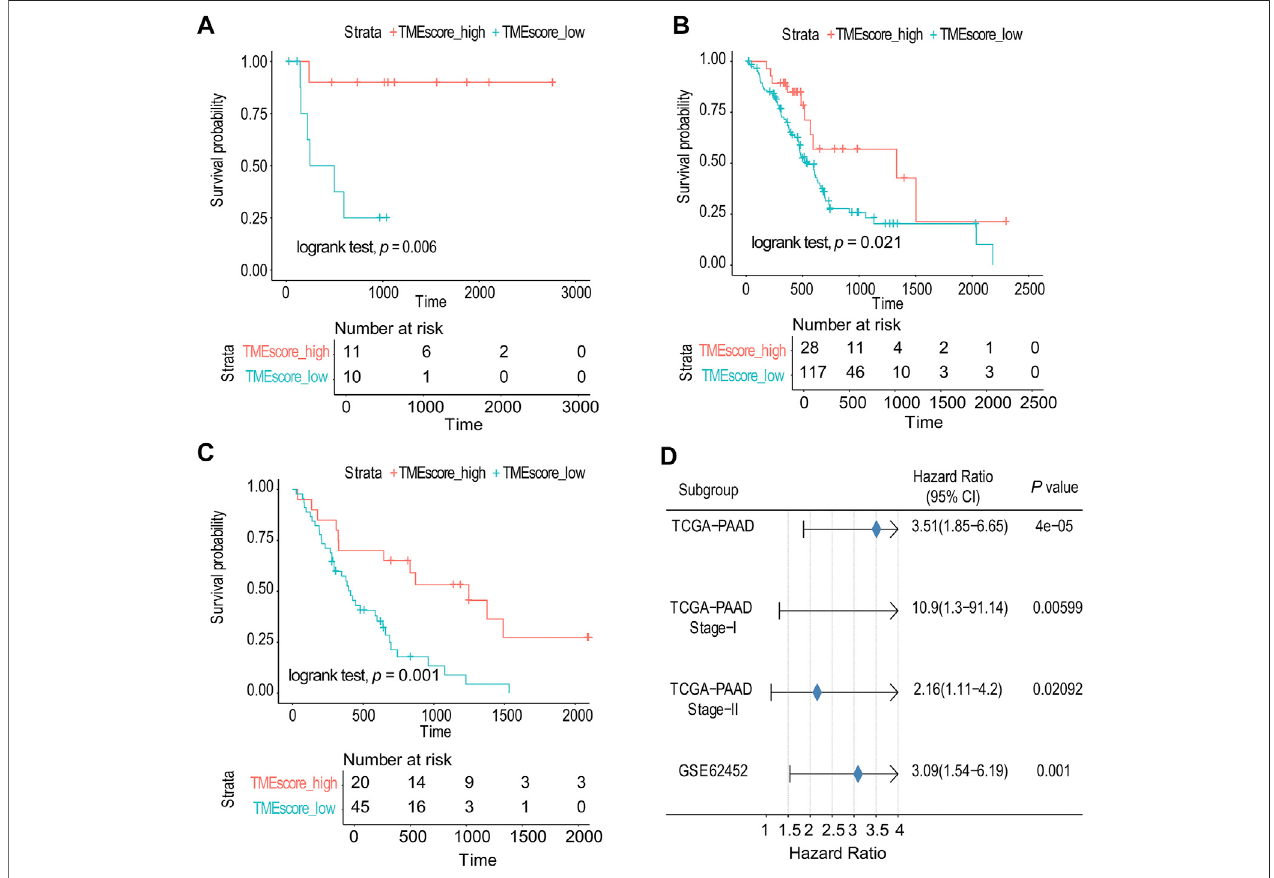
FIGURE 3 | TMEscore model was veri fi ed in TCGA and GSE databases. (A) Survival analysis of phase I in TCGA-PAAD. (B) Survival analysis of phase II in TCGA- PAAD. (C) GSE62452 database survival analysis validation. (D) Validation and model evaluation were performed using TCGA-PAAD and GSE62452 samples.